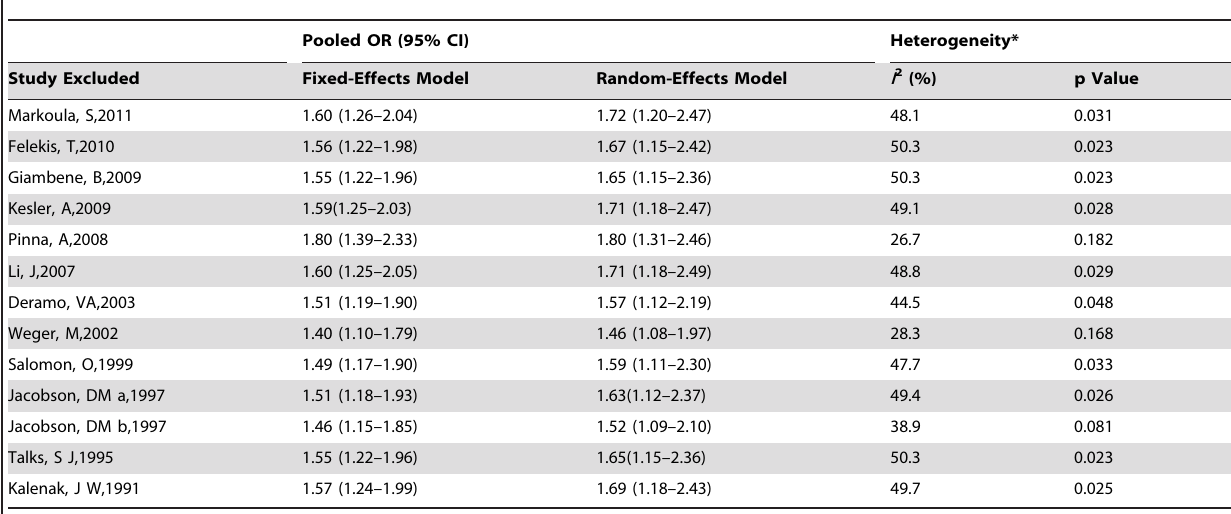
Table 3. Results of leave-one-out sensitivity